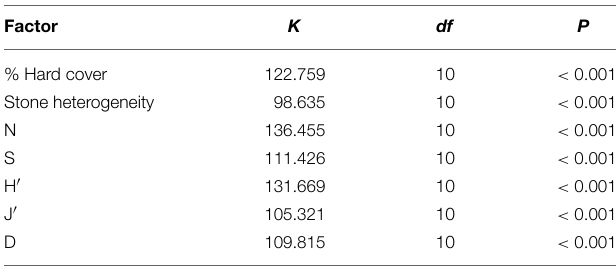
TABLE 1 | Results of Kruskal-Wallis tests for differences in biotic and abiotic factors among stations. Factor K df P % Hard cover 122 .